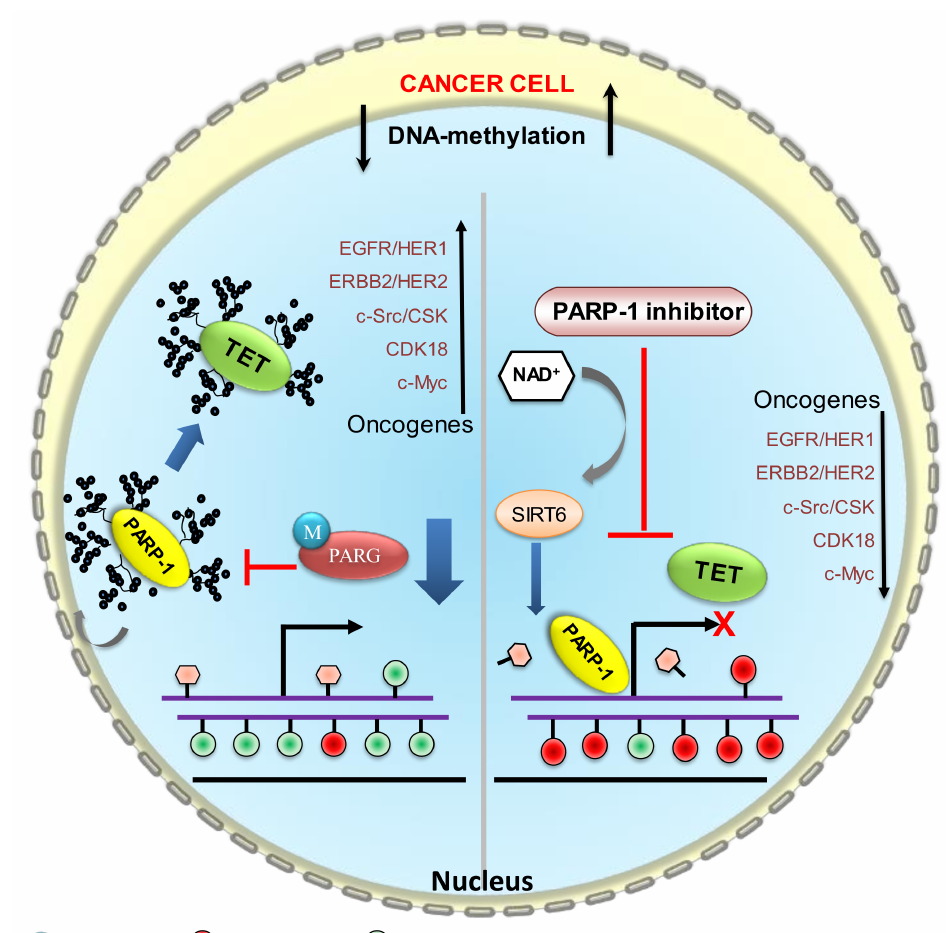
Figure 6. TET1 stimulates the activity of PARP1 independently of DNA damage. Poly(ADP-ribosyl)ation of TET1 by PARP1 increases TET1 enzymatic activity and regulates the hydroxylase activity of the DNA demethylation processes. Poly(ADP-ribosyl)ation of TET1 preserves the unmethylated state and activates the transcription of oncogenes. The PARP1 inhibitor inhibits the enzymatic activity of TET1, as a result, the expression of oncogenes is downregulated due to hypermethylation. Availability of NAD + makes SIRT6 enzymatically active to remove the acetyl group from histone proteins, further downregulating the transcription of